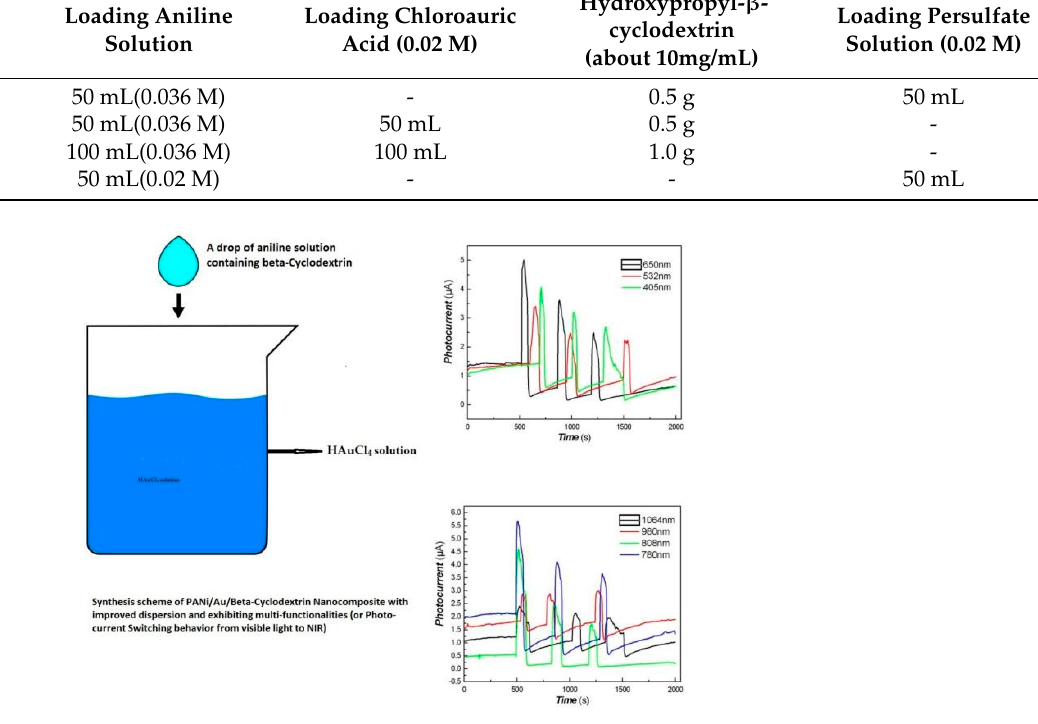
Figure 1. Synthesis scheme of PANi/Au/Beta-cyclodextrin nanocomposite with improved dispersion stability and multi-functionality.